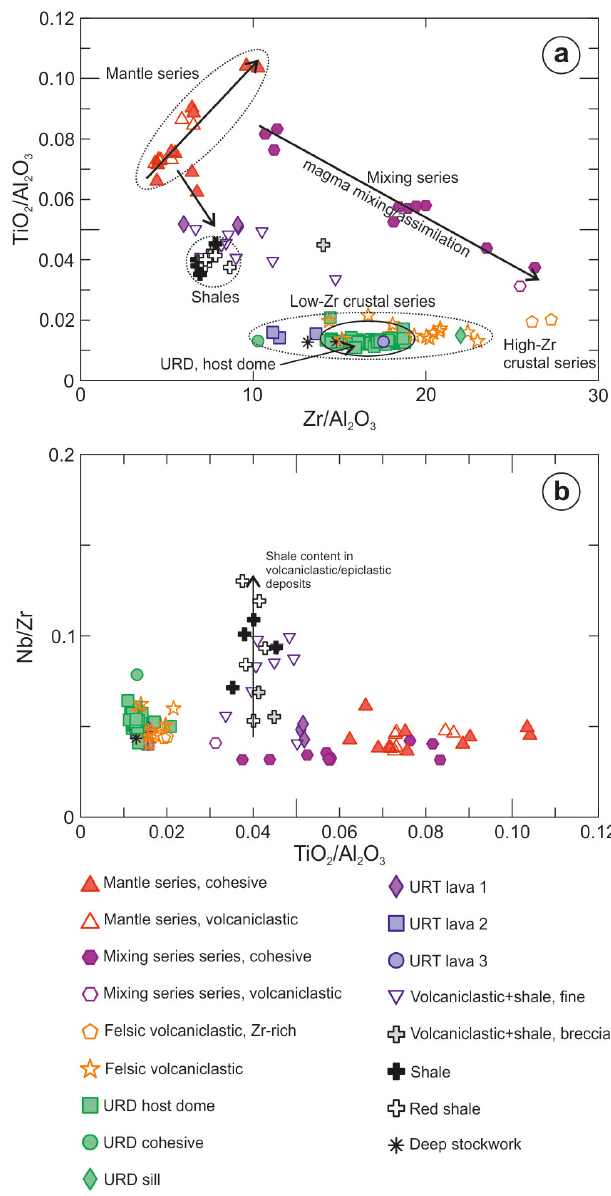
Figure 8. Whole rock geochemistry discrimination diagrams of rocks in the Aguas Teñidas deposit host stratigraphic sequence based on immobile elements. (a) TiO 2 / Al 2 O 3 vs. Zr / Al 2 O 3 . (b) Nb / Zr vs. TiO 2 / Al 2 O 3 . Ratios are calculated from major (ox- ides in wt%) and trace (µgg − 1 ) element